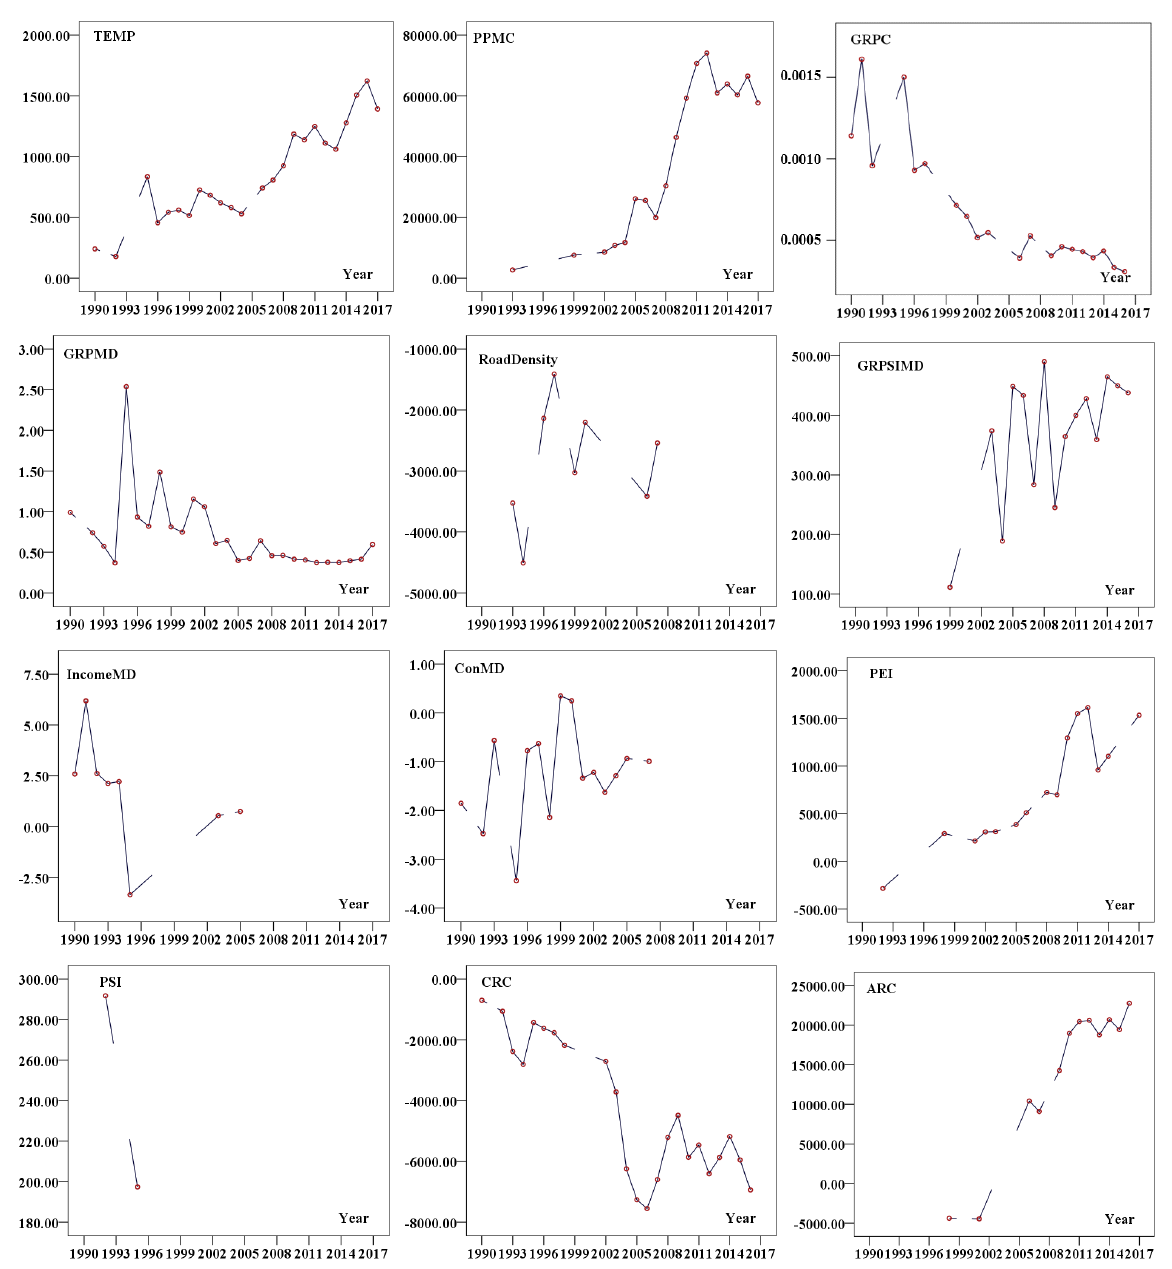
Figure A12. Annual contributions from individual indicators to land-use intensity in Chinese cities from 1990 to 2017. Note: the values of individual indicators in the above charts are the regression coefficient.